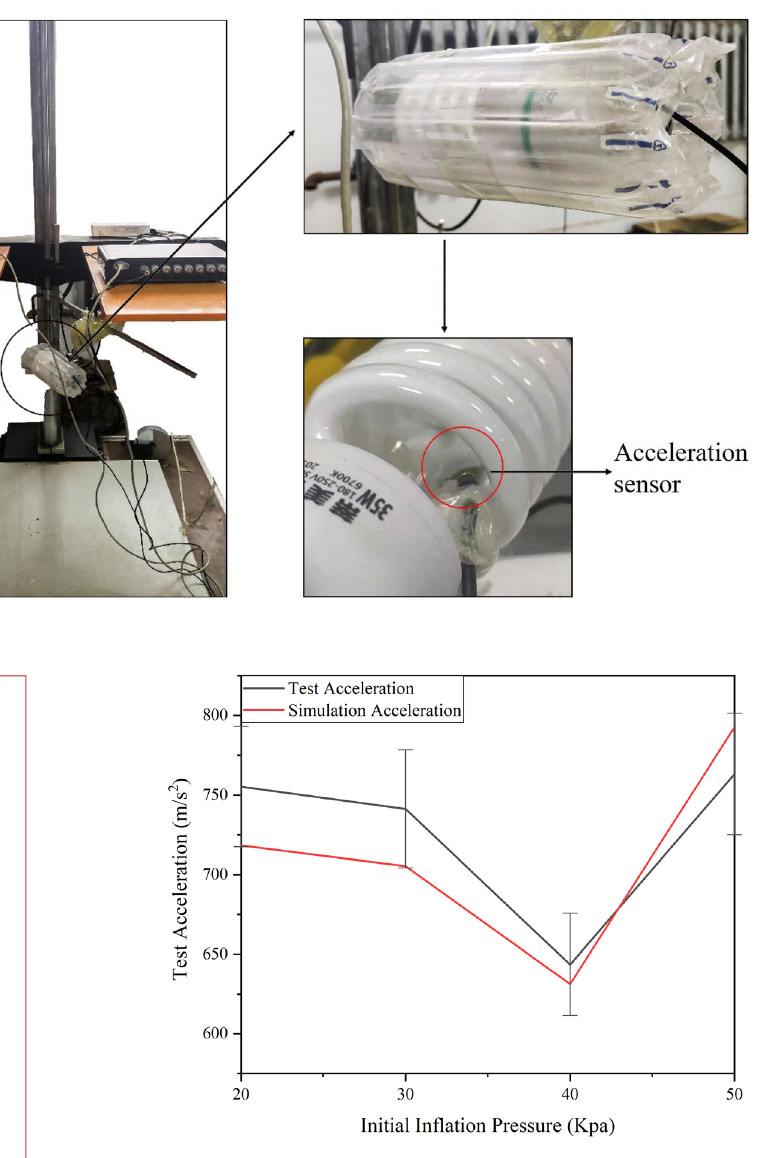
Fig. 16 Drop test acceleration and simulated acceleration under different initial inflation